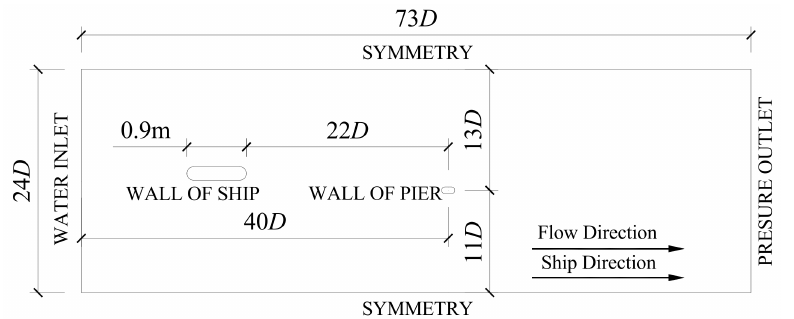
Figure 15. Numerical model computing domain.